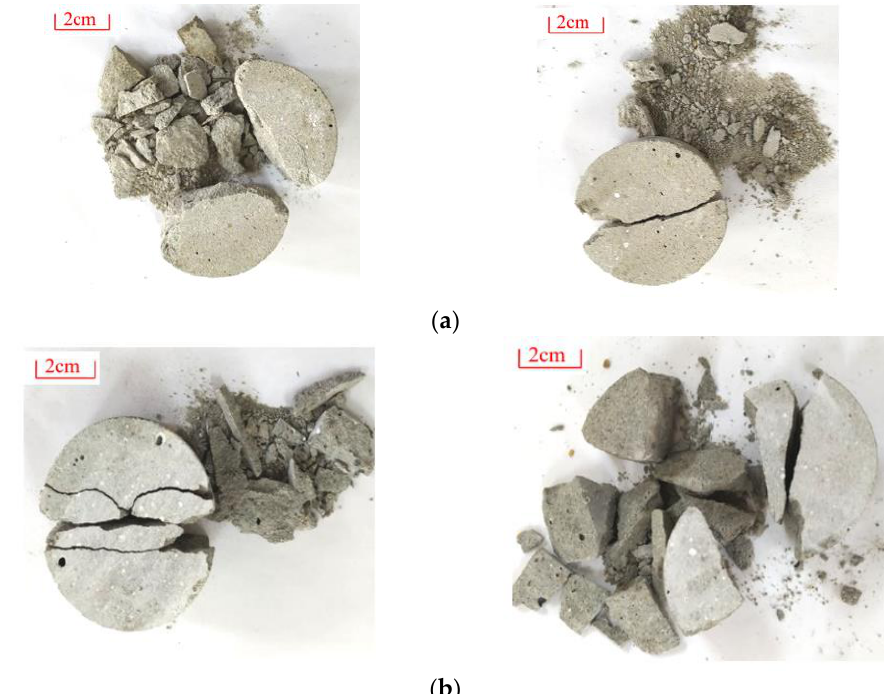
Figure 12. Fracture failure modes of specimens under different impact pressures. ( a ) Impact crushing form of mudstone-like material (0.2 MPa crushing form), ( b ) impact crushing form of sandstone-like material (0.2 MPa crushing form).